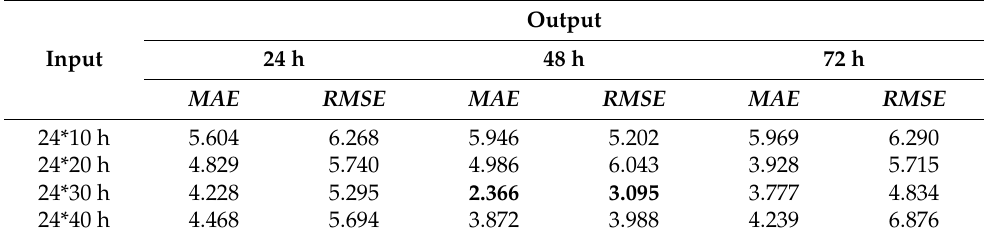
Table 3. MAE and RMSE with different input and output variable values (Unit: µ g/m 3 ).